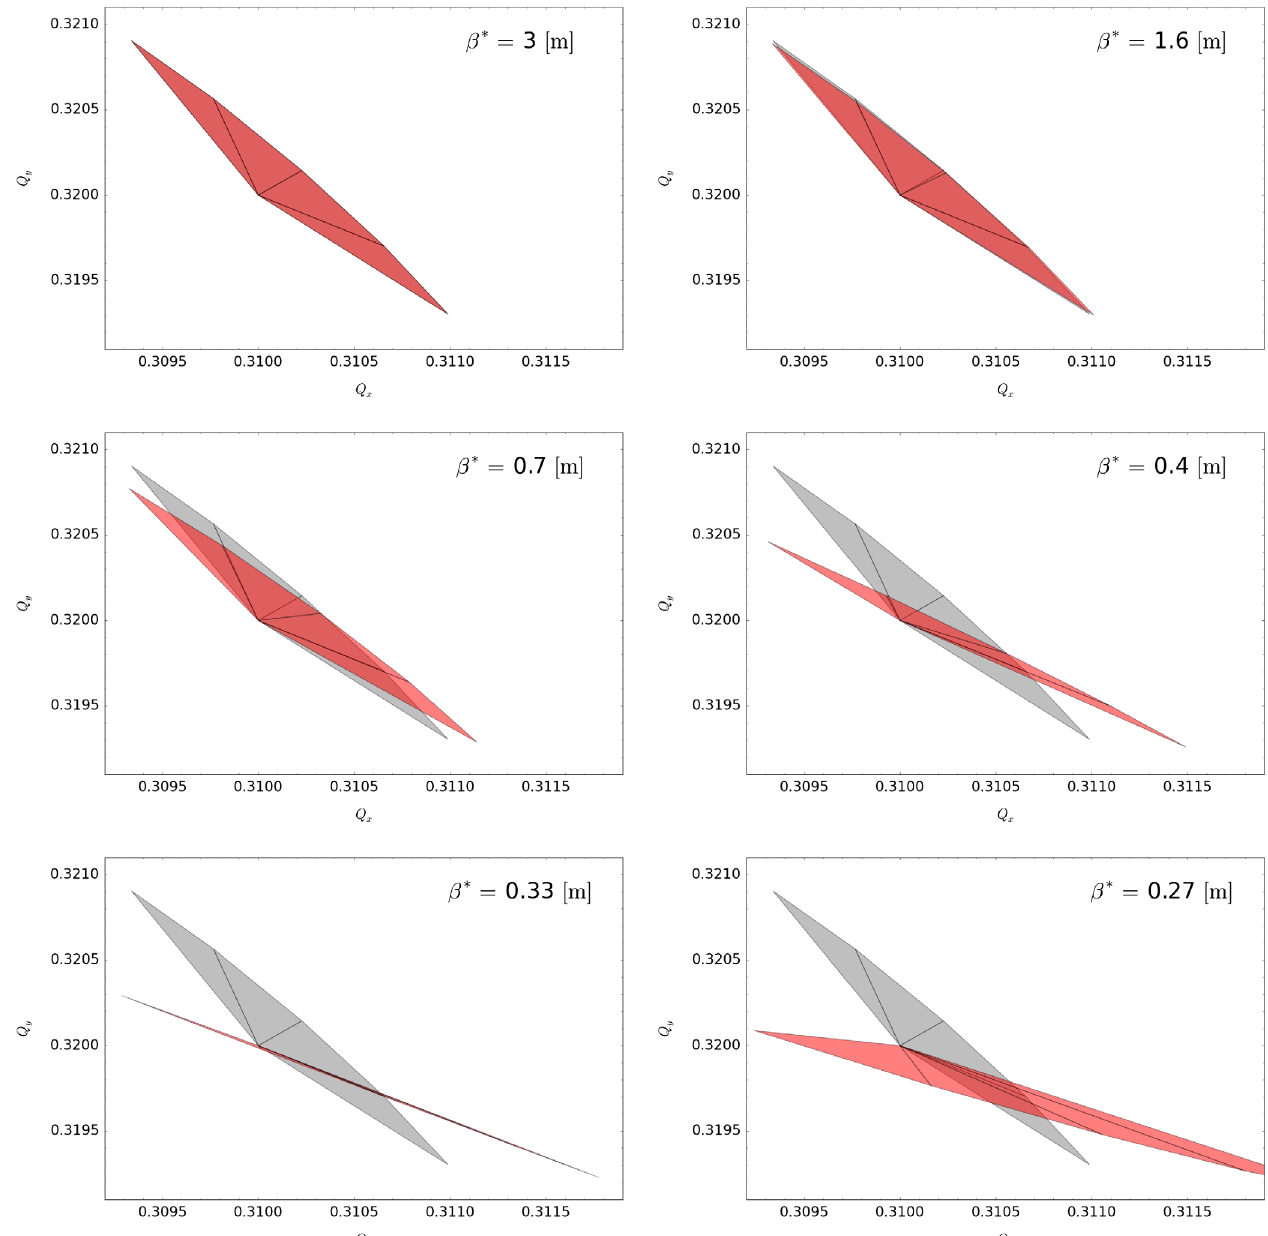
FIG. 1. Distortion of tune footprint through the β (cid:1) squeeze. Displayed footprints are defined by first-order detuning coefficients obtained via simulation. Simulations consist of an effective model of normal octupole errors in IR1 (ATLAS) and IR5 (CMS) which reproduces the observed detuning, together with Landau octupoles powered as per operation for luminosity production in 2016. Grey regions show the desired footprint, expected in the absence of the IR contribution. Red regions show the inferred footprint if IR-octupole errors are